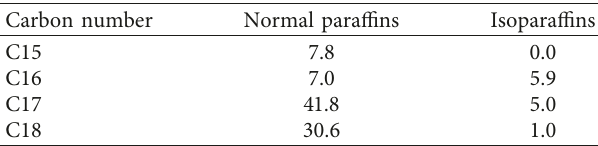
Table 2: Composition of HUCO used (% w/w) [28].